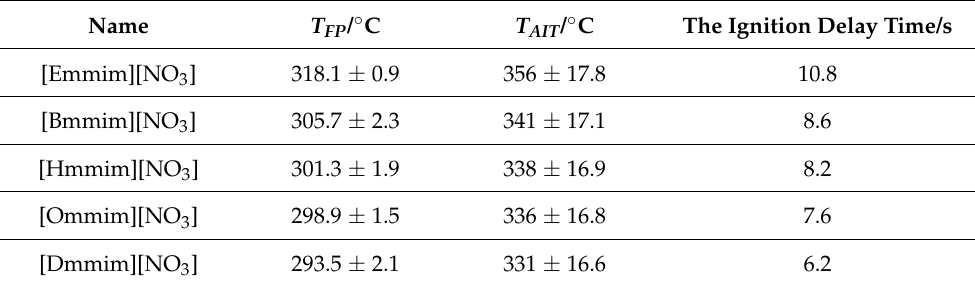
Table 3. The data of autoignition temperature and flash point